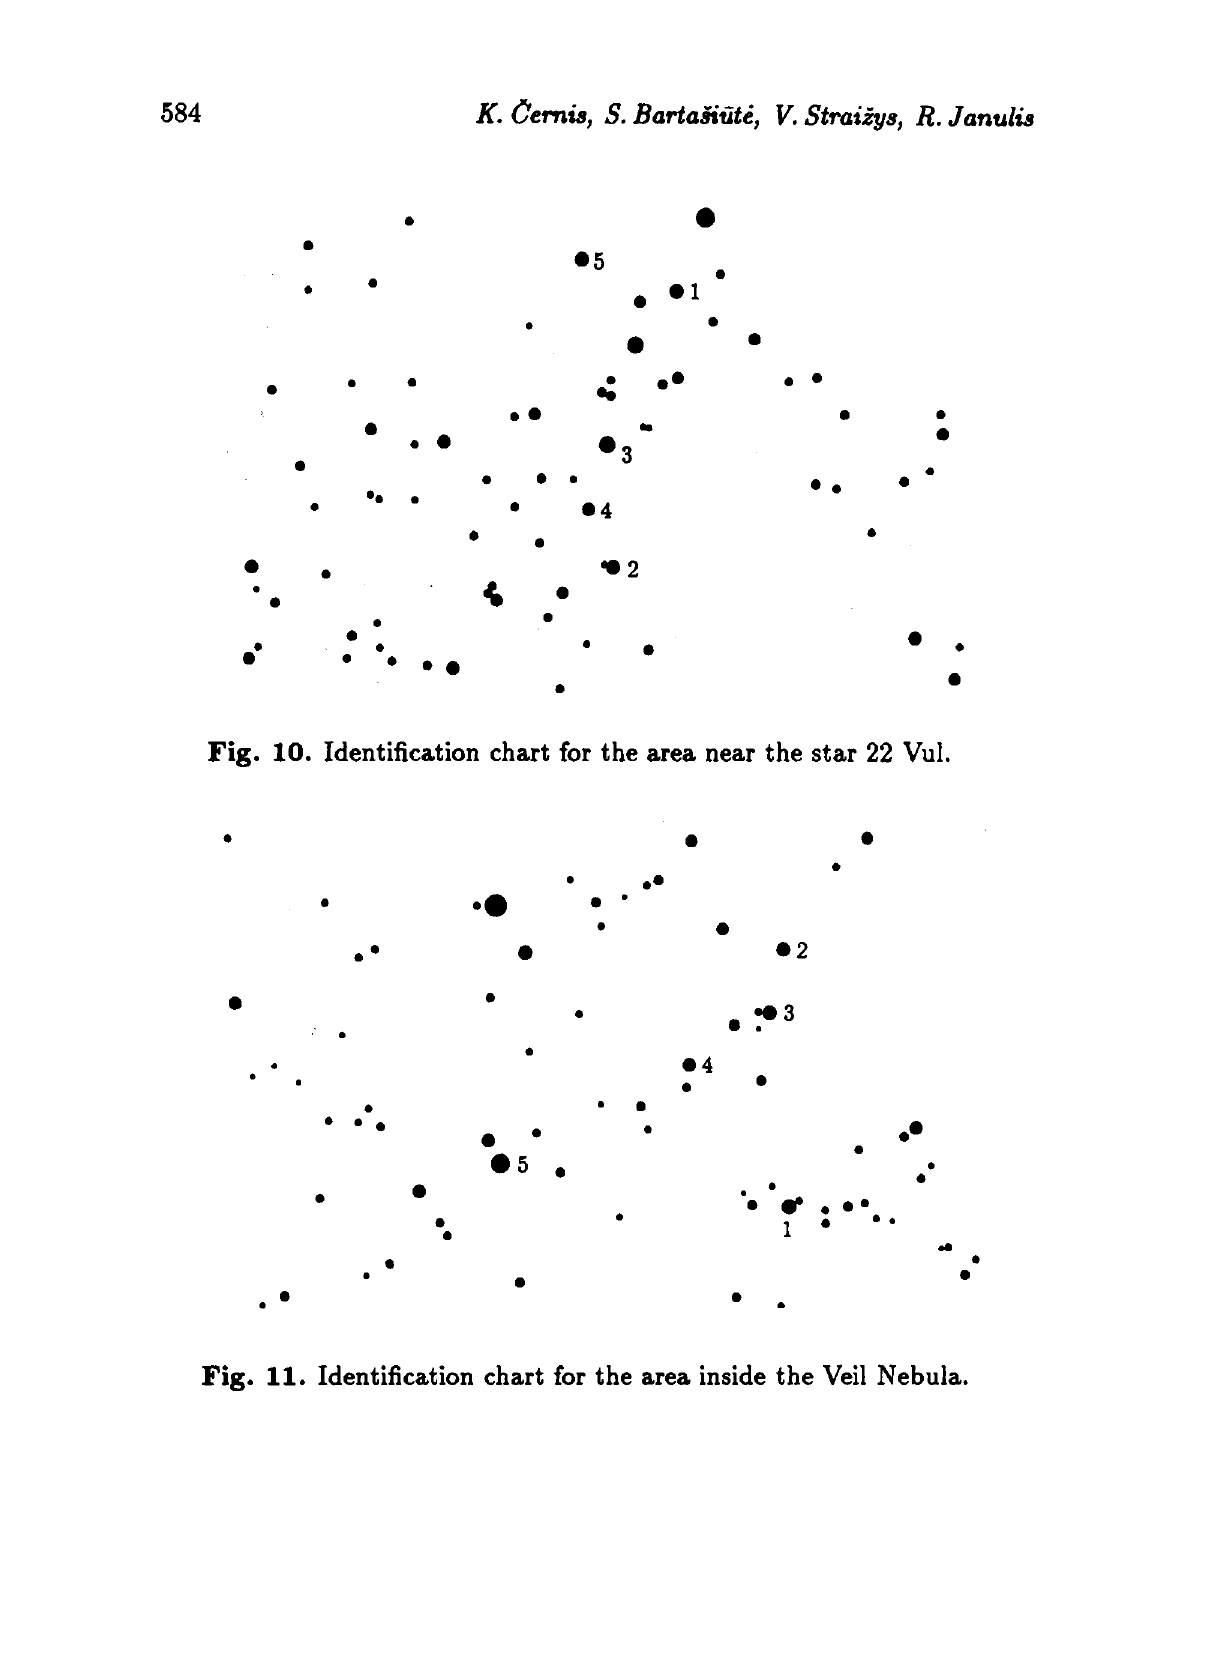
Fig. 11. Identification chart for the area inside the Veil